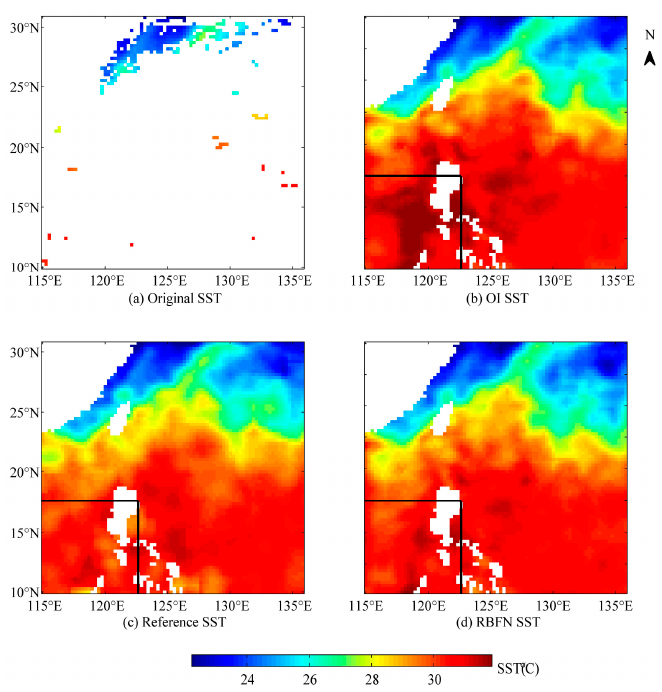
Figure 8. The distributions of ( a ) original SST samples; ( b ) OI SST; ( c ) reference SST; and, ( d ) RBFN SST on 13 June 2014. The region outlined by the square is used for comparison in detail. White areas in the images indicate no data or land.